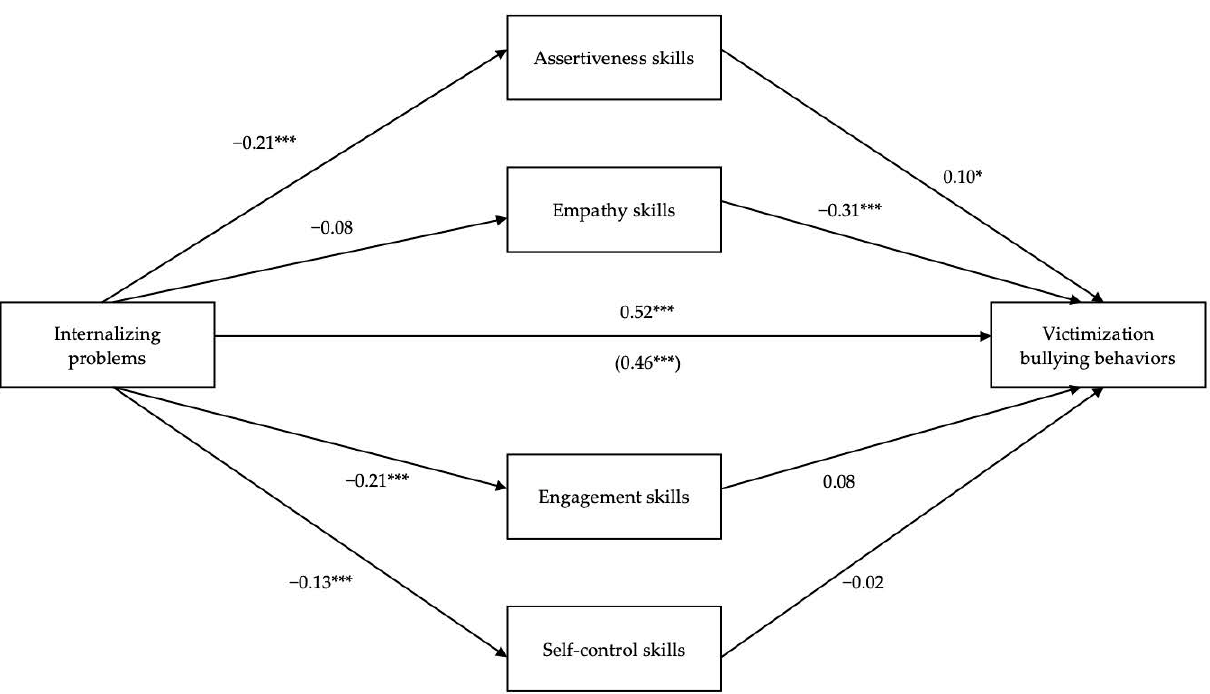
Figure 2. The mediating role of social skills in the relationship between internalizing problems and victimization bullying behaviors (N = 669). * p <0.05; *** p <